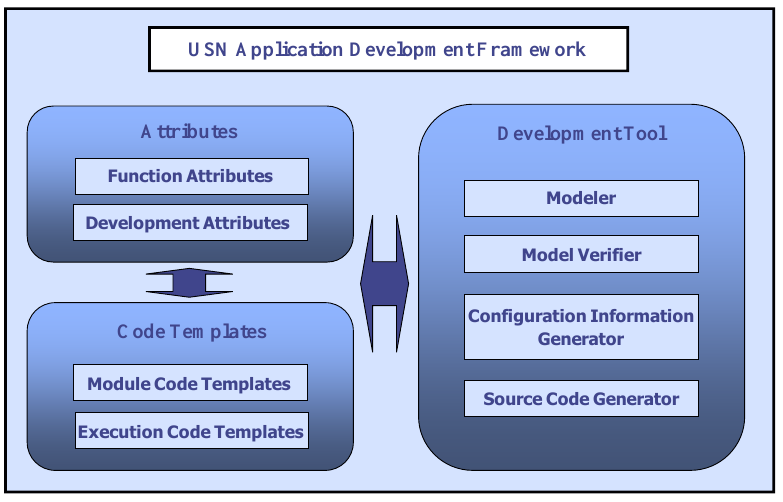
Figure 1. USN application development